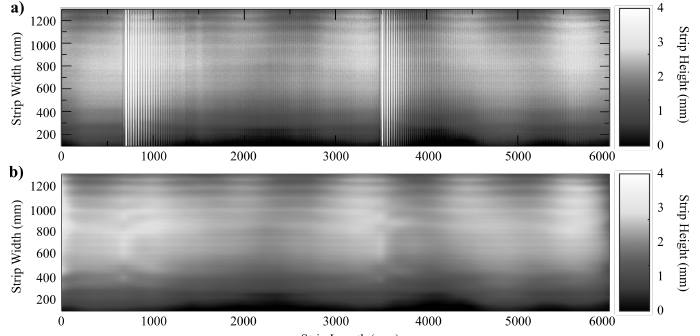
Figure 12. ( a ) Sensor raw data for a S500MC high yield steel coil with with observed periodic transient impulses and background noise. ( b ) Denoising results of the sensor raw data using the proposed Hermite interpolation filtering